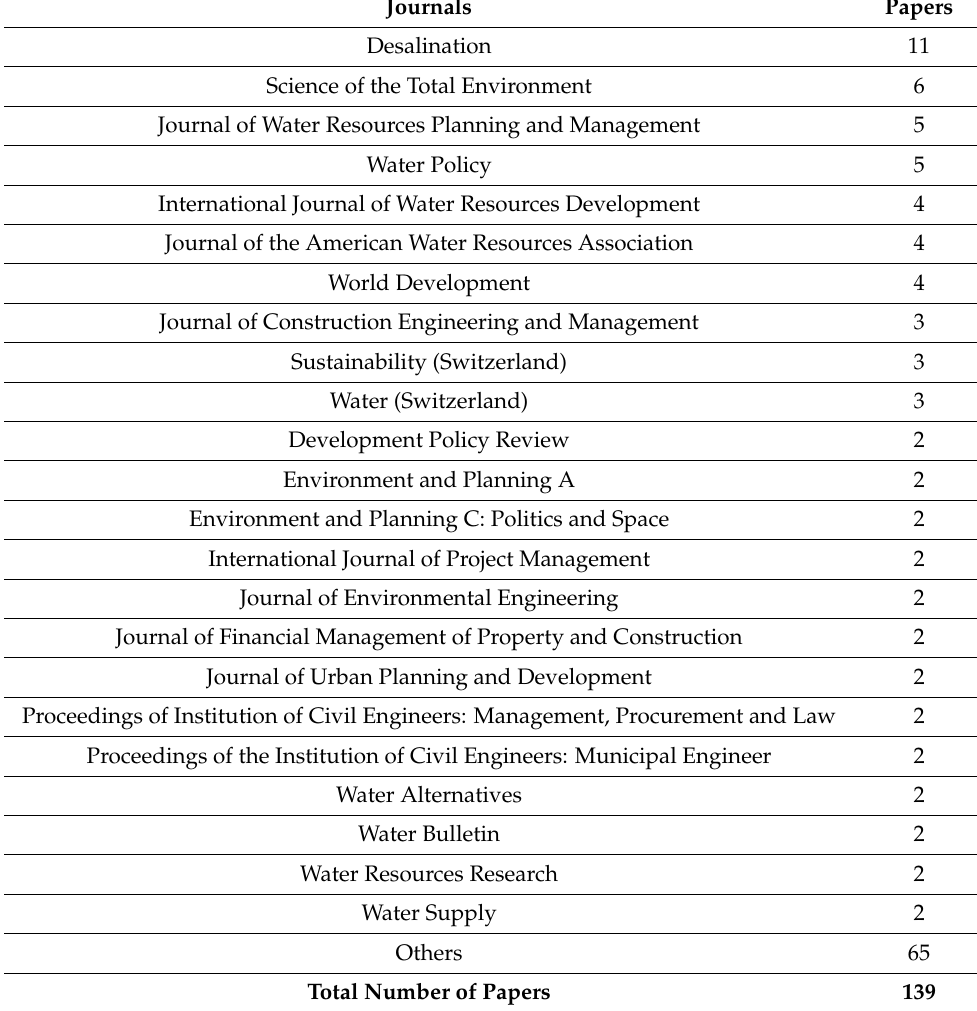
Table 2. Number of papers by